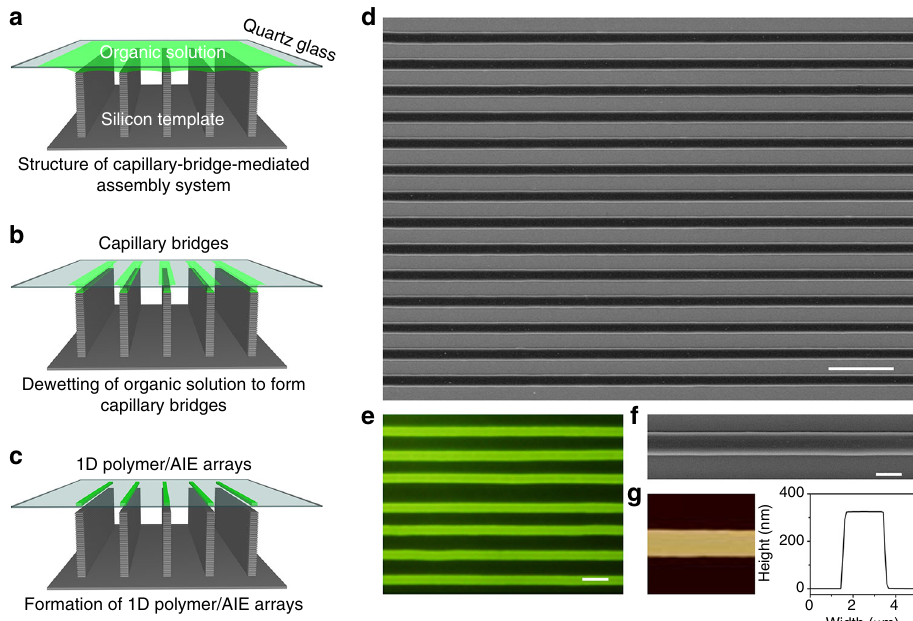
Fig. 1 Fabrication of 1D polymer/AIE molecule microwires array. a – c Scheme showing the capillary-bridge-mediated assembly method for assembly of 1D polymer/AIE molecules microwires arrays. A micropillar-structured template, with lyophobic sidewalls and lyophilic tops, is employed. Then, a thin- fi lm dispersion of polymer/AIE molecule solution is sandwiched between the micropillar template and quartz glass substrate to form the structure of capillary- bridge-mediated assembly system. Dewetted liquid fi lm is gradually divided into capillary bridges, which fi nally generate 1D polymer/AIE molecule microwires array. d SEM image and e fl uorescent image of large-area 1D polymer/AIE molecule microwires array fabricated on quartz glass. The scale bars are 20 μ m and 5 μ m for ( d ) and e , respectively. f Zoom-in SEM image of ( d ), and g AFM image showing an individual 1D microstructure with uniform composition, smooth surface, and straight boundary (ca. 2.0 μ m in width and ca. 320 nm in height). The scale bar is 2 μ m. The PES is employed, and the AIE molecule is AnPh